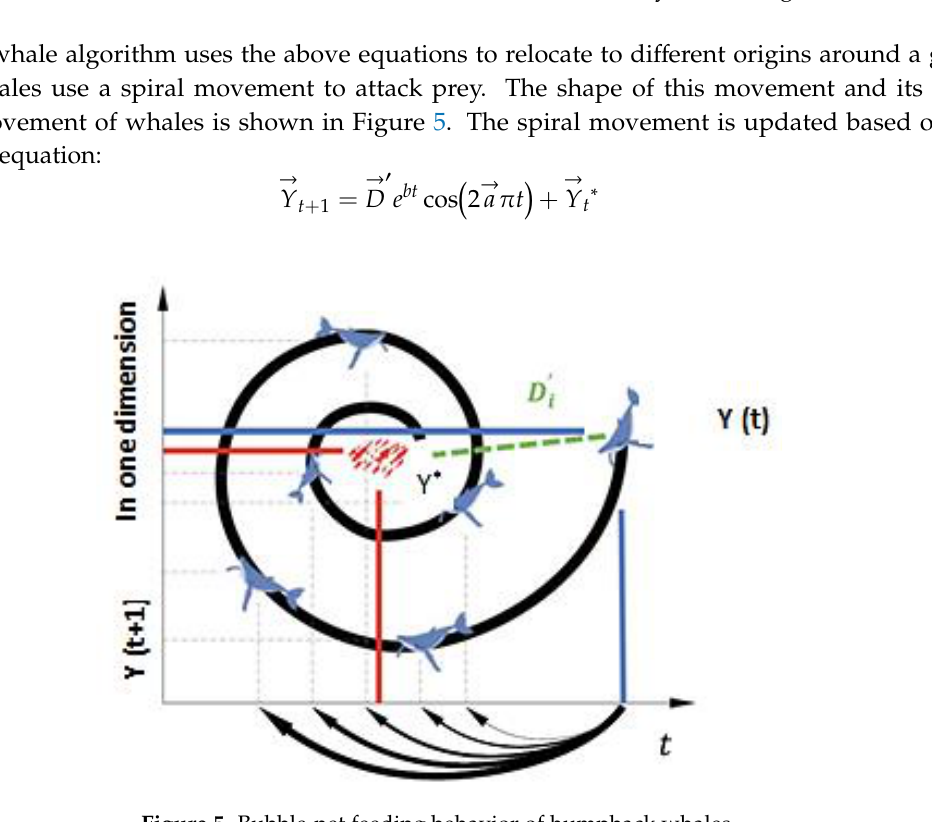
Figure 5. Bubble-net feeding behavior of humpback whales.